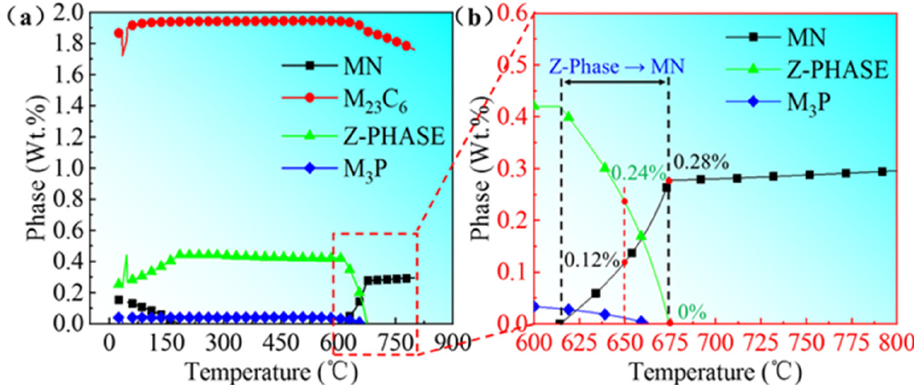
Jmat-Pro software (version 9.0, Sente Software Ltd., Guildford, UK) and ( b ) the area of